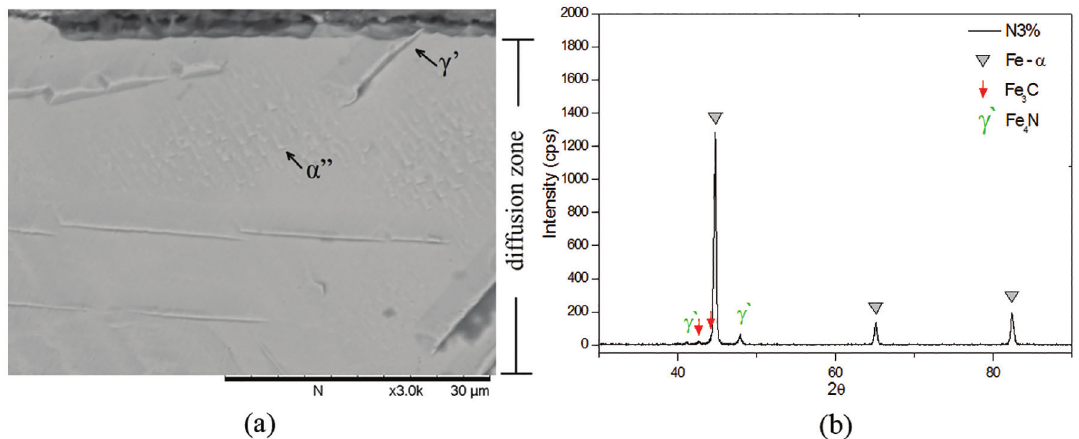
Figure 4: Sample N3%: (a) scanning electron microscopy and (b) XRD.